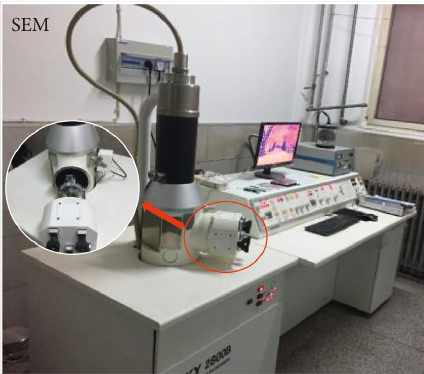
Figure 3: Scanning electron microscope (SEM).